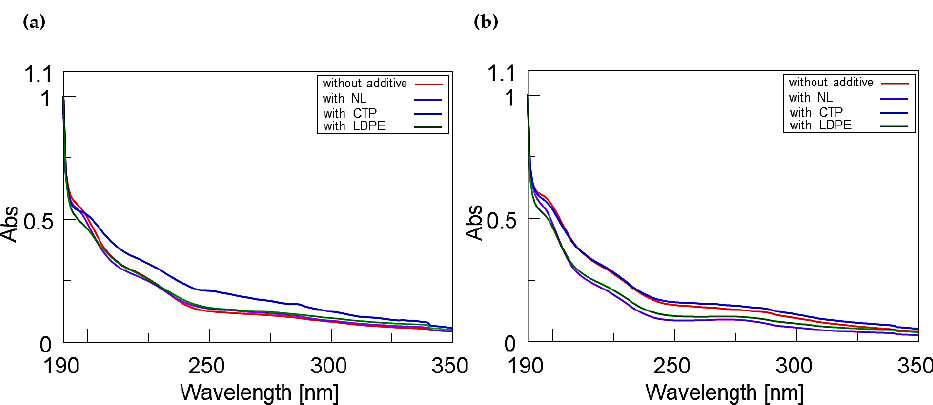
Figure 6. The UV spectra of methanol ( a ) and water ( b ) condensates.